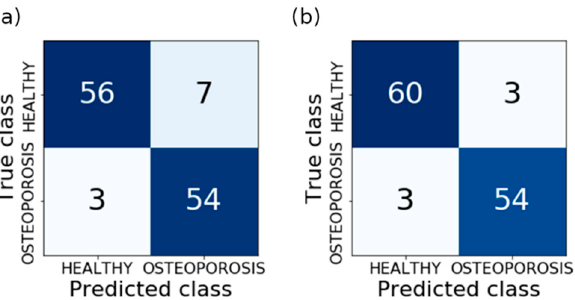
Figure 7. Confusion matrices: ( a ) model 5 for bone reconstruction; ( b ) models 2, 4, 5, 8 and 9 for soft tissue reconstruction.